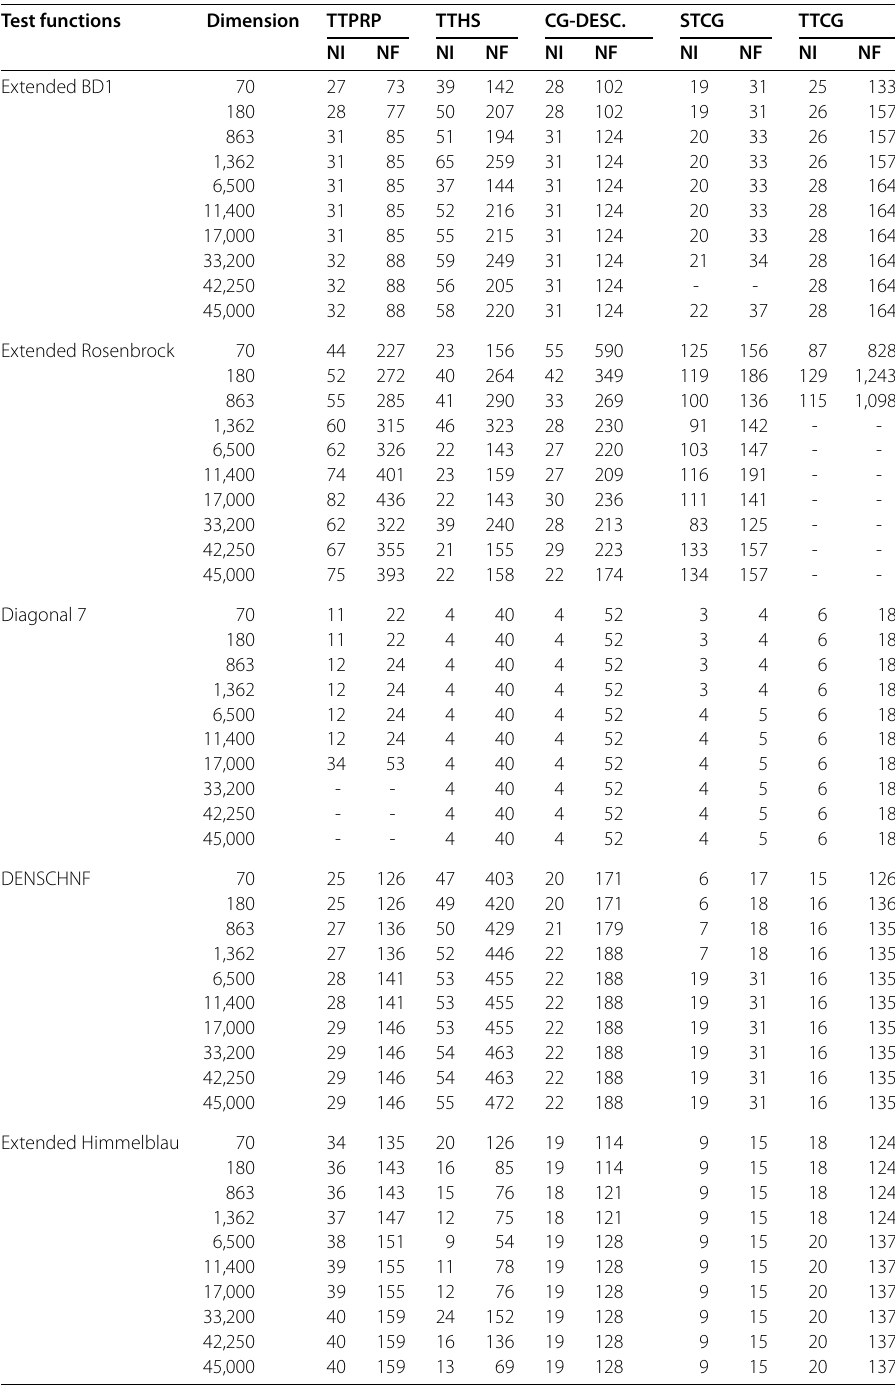
Table 1 Numerical results of TTPRP, TTHS, CG-DESCENT, STCG, and